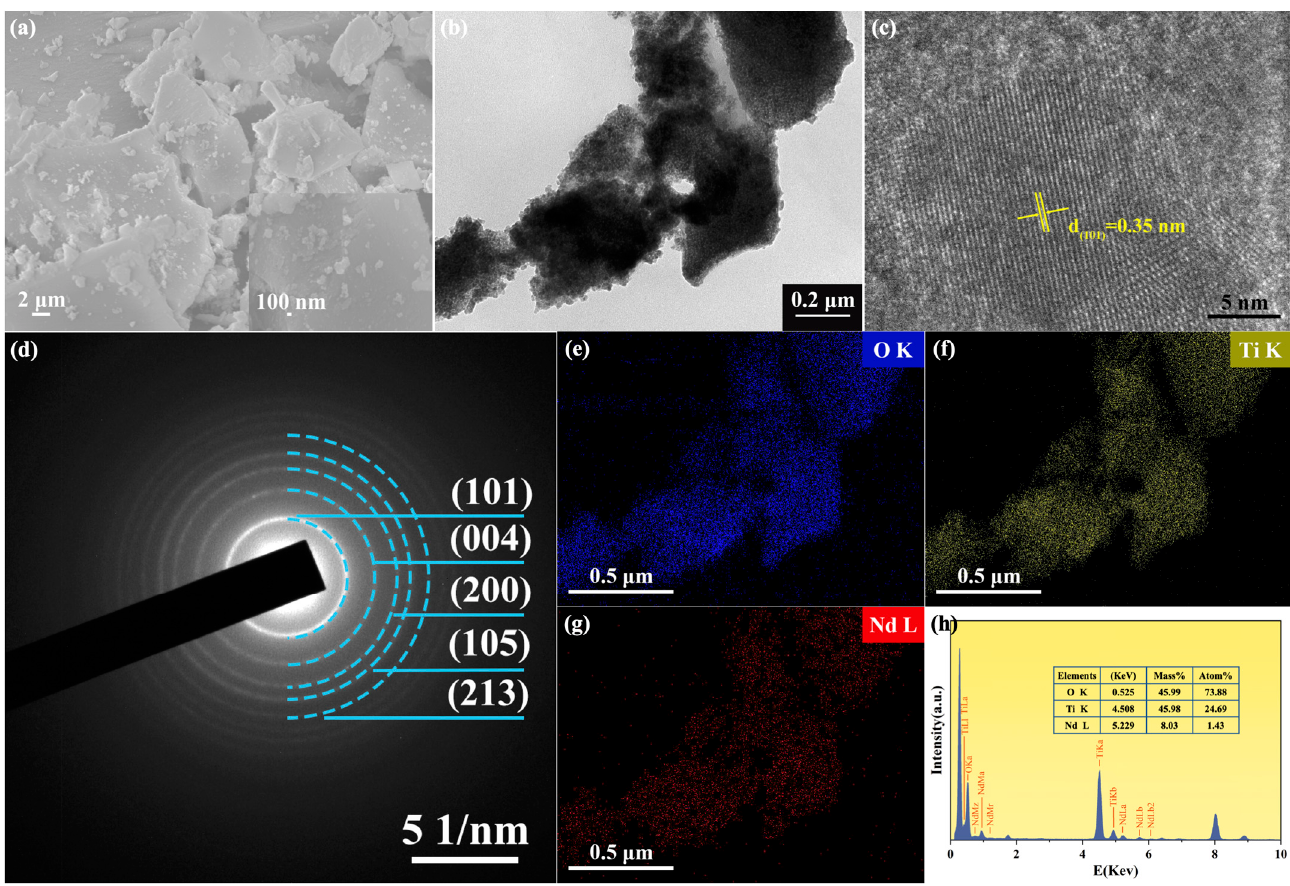
Figure 2. Characterization analysis of the 2%Nd-TiO 2 NPs. ( a ) SEM and ( b ) TEM images; ( c ) HRTEM image showing lattice space; ( d ) SAED pattern mainly showing the (101), (004), (200), (105), and (213) crystal faces; the element mapping of ( e ) O, ( f ) Ti, and ( g ) Nd; ( h ) EDS spectrum.